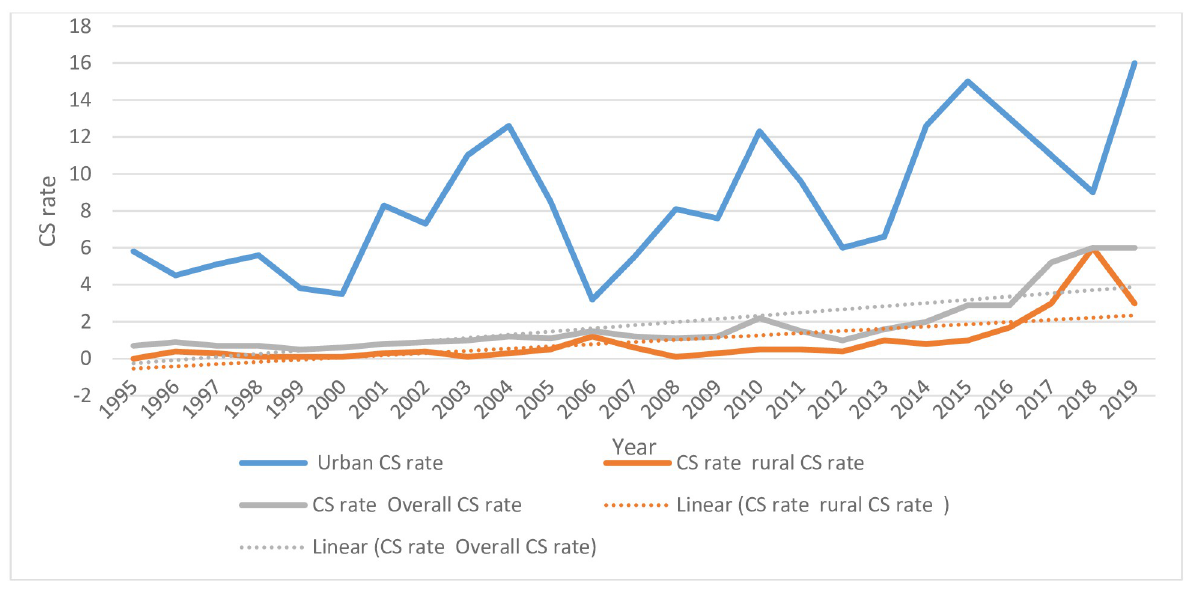
Fig 3. The trend of CS rate in the Urban and rural part of Ethiopia data from (1995–2019).